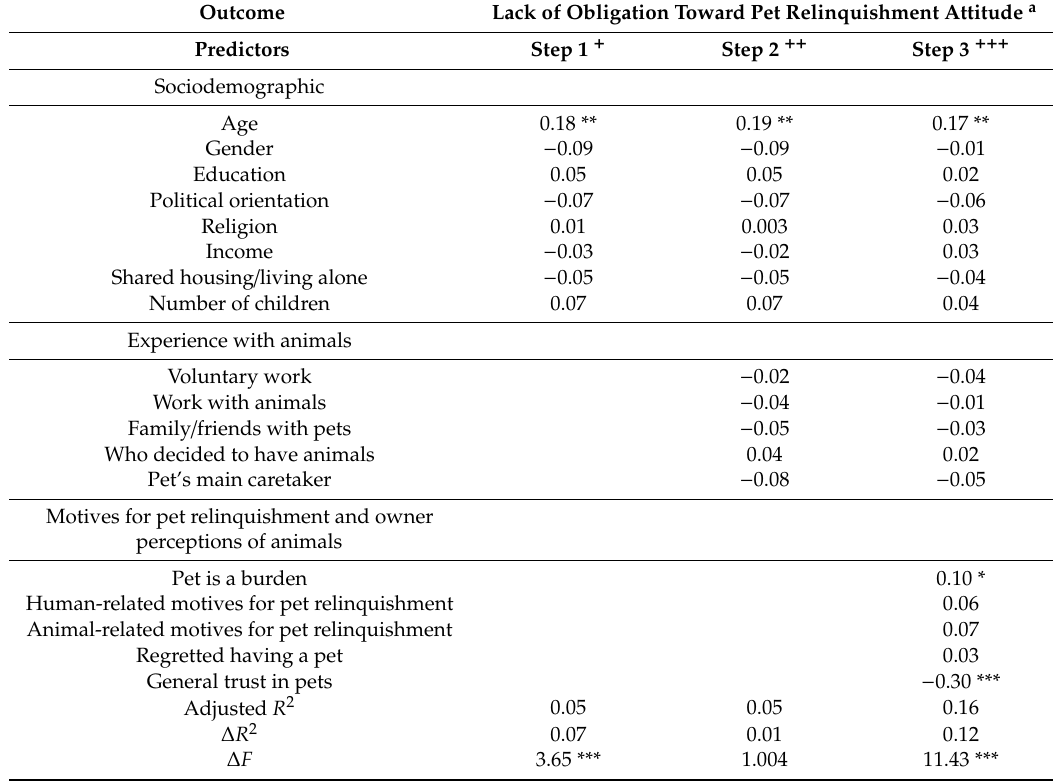
Table 4. Correlates of lack of obligation toward pet relinquishment attitude (standardized regression coe ffi cients and associated